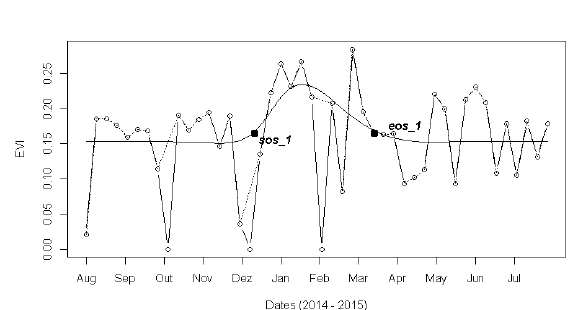
Figure 7. Time series EVI spectral profile for perennial crop sample of one of the citrus farm (similar to mango).